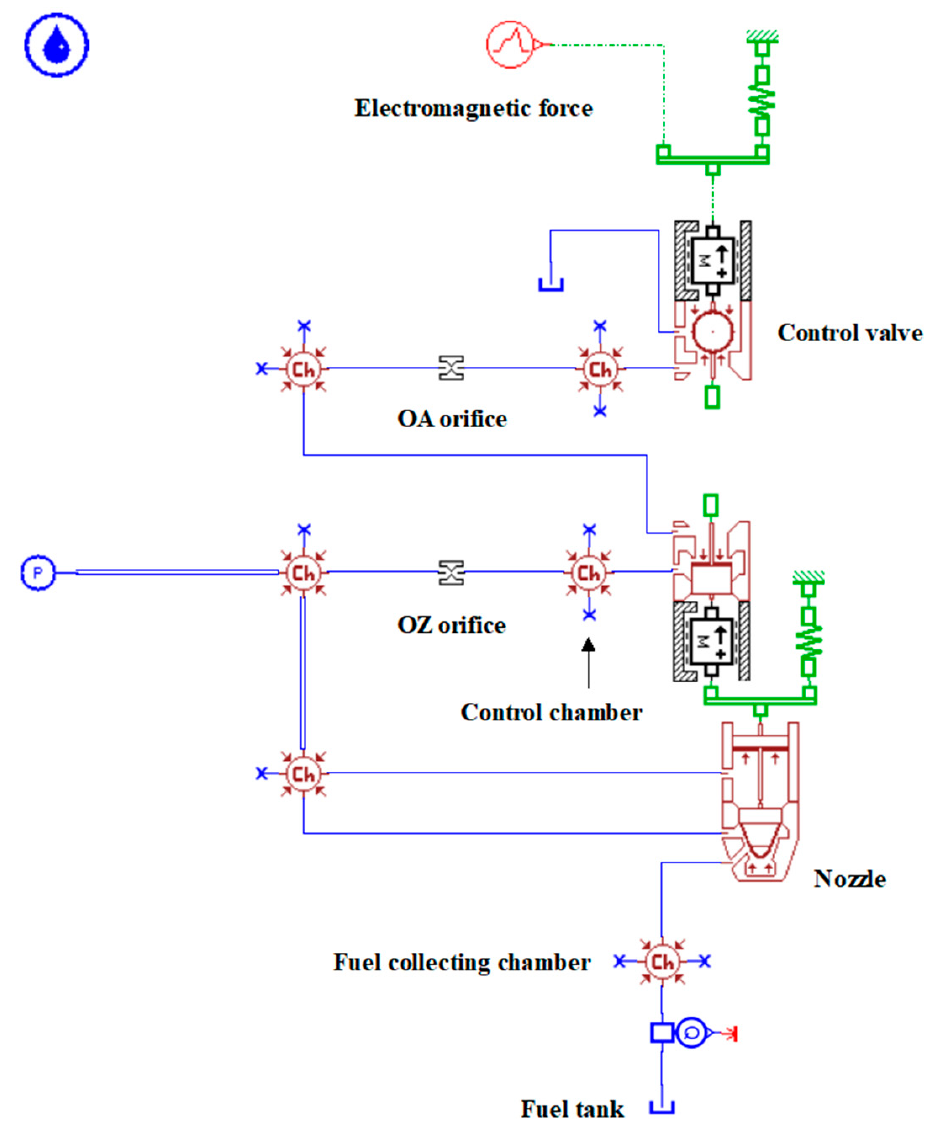
Figure 2. The simulation model of CR injector under isothermal flow.